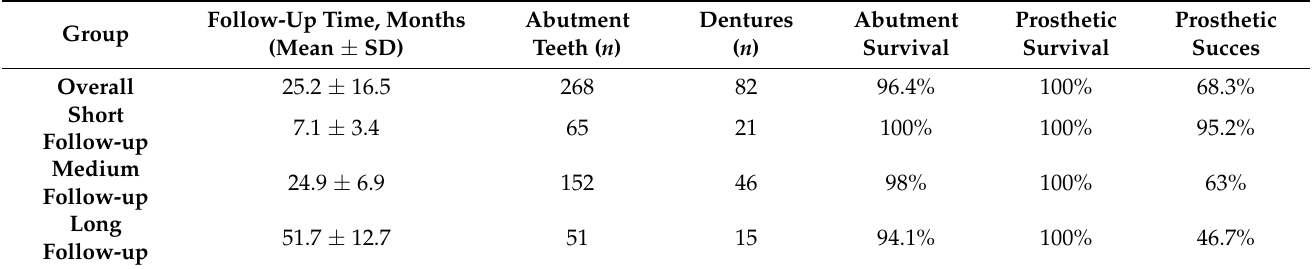
Table 1. Summary of findings differentiated by the follow-up groups.